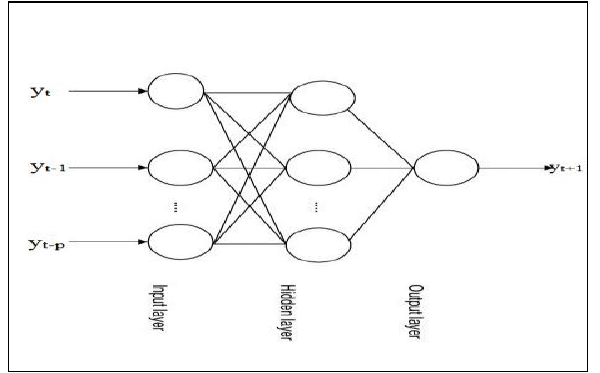
Figure 3. Feed forward neural networks for time series forecasting